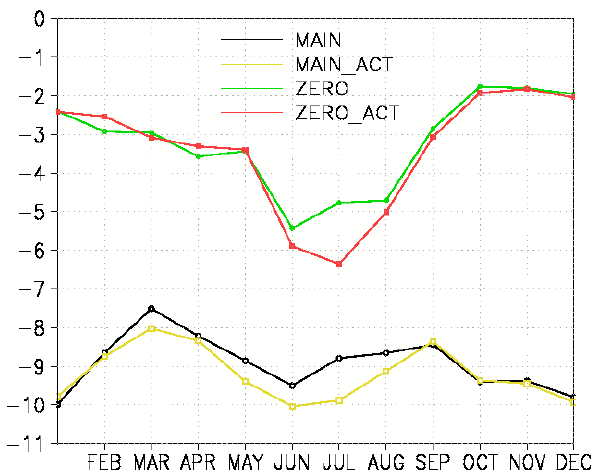
Figure 4. Seven-year monthly mean radiative forcing (in Wm − 2 ) in the area 65–90 ◦ E, 5–35 ◦ N at the surface in the MAIN and MAIN_ACT simulations with GAINS emissions without aerosol– cloud activation (black) and with aerosol–cloud activation (yel- low) and in the ZERO and ZERO_ACT simulations without an- thropogenic emissions without cloud activation (green) and with aerosol–cloud activation (red).